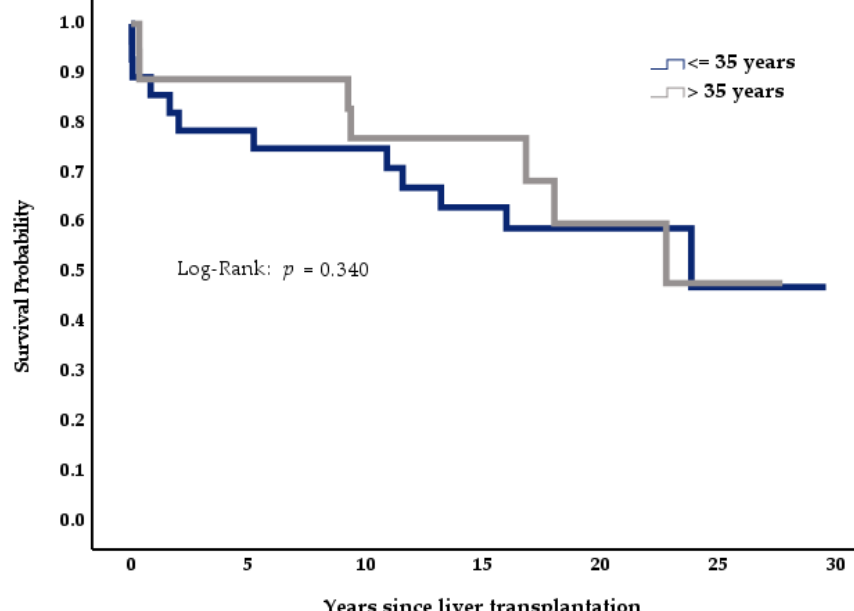
Figure 4. Impact of age on survival, n = 46.